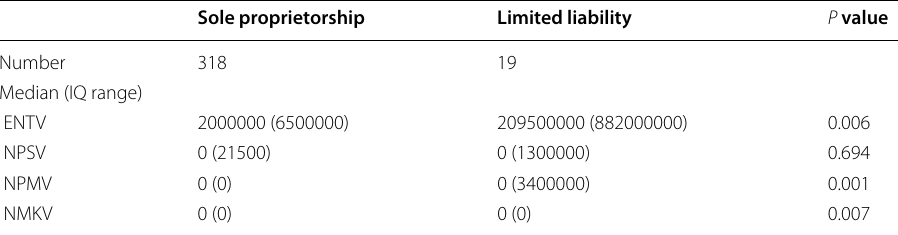
Table 5 Differences between sole proprietorships and limited liability enterprises in the value of innovations carried